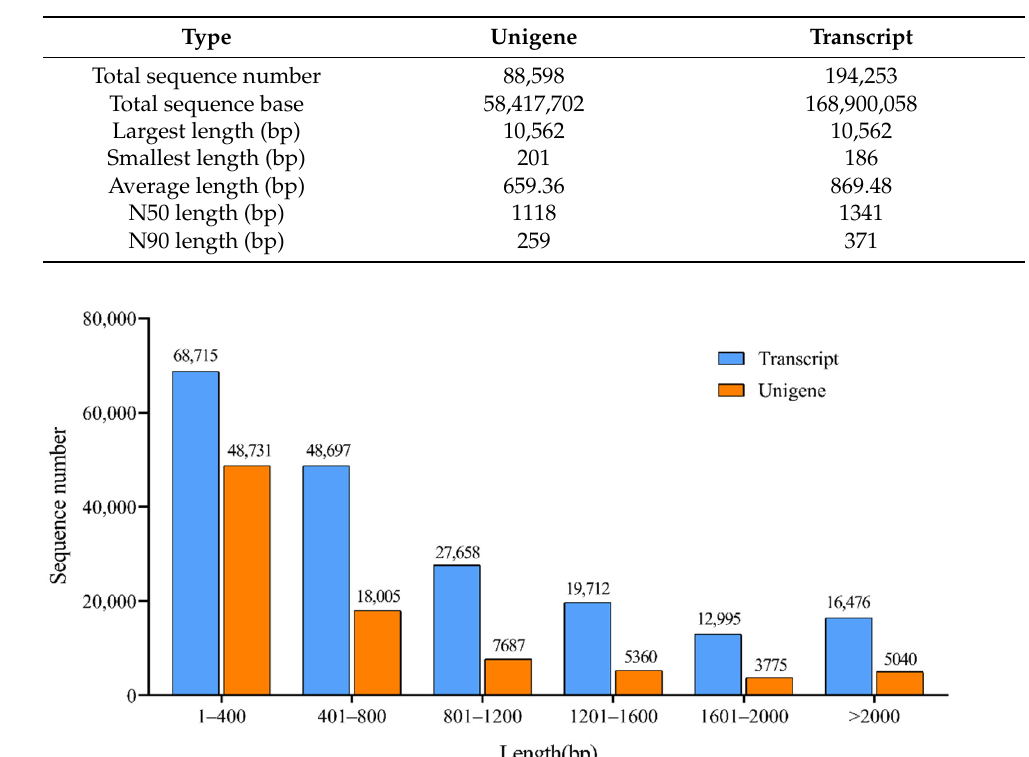
Figure 2. Transcript and unigene length distribution. Table 2. Statistics of sequencing and assembly results.